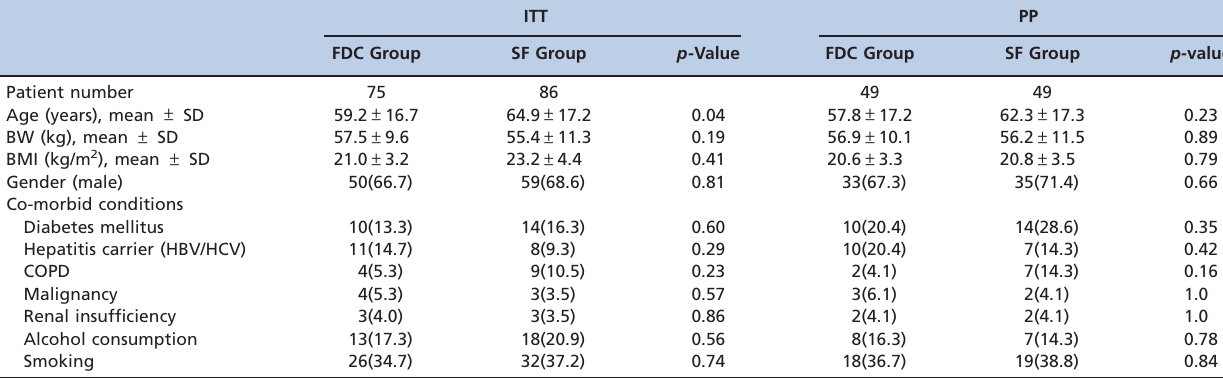
Table 1 - Demographic and clinical characteristics of the study